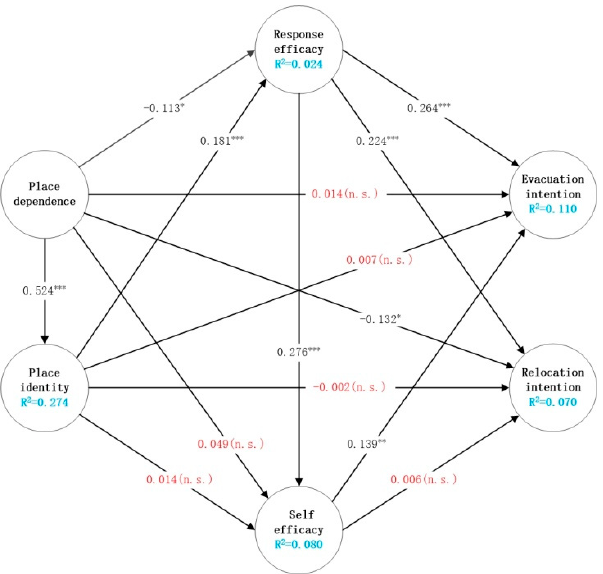
Figure 3. Test of research model. Note: *** p < 0.01; ** p < 0.05; * p < 0.1; n.s. not significant.